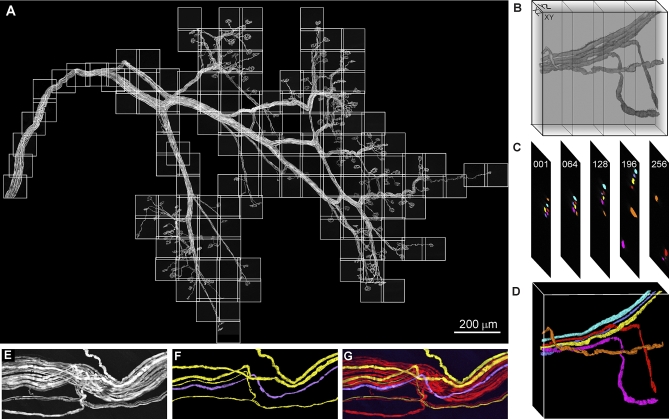
Method for Reconstructing Neuromuscular Connectomes(A) All the axons (labeled with YFP) in an interscutularis muscle were imaged by confocal microscopy with motorized stage. A montage of 146 overlapping image stacks (white squares) provided the dataset (total ∼43 GB) for connectome reconstruction.(B–D) Each XY stack (B) was digitally resampled along an orthogonal axis (x or y) so that most axons could be followed in cross-sections (C). Axonal contours in cross-sections were delineated, color-coded, and rendered in 3D (D) using semi-automatic tracing software.(E–G) Reconstruction accuracy was tested by tracing motor axons in a muscle from a triple transgenic mouse in which all axons expressed an orange fluorescent protein (KOFP) and a small subset of axons expressed in addition either CFP or YFP. (E) Appearance of the nerve in the KOFP channel. From an adjacent section we selected several doubly labeled axons and reconstructed them in this volume using the KOFP channel only. (F) Monochromatic reconstruction results for doubly labeled axons. Lavender, KOFP + CFP; yellow, KOFP + YFP. (G) All three fluorescent channels shown for the volume. The results were identical for the doubly labeled axons (compare [F] and [G]).